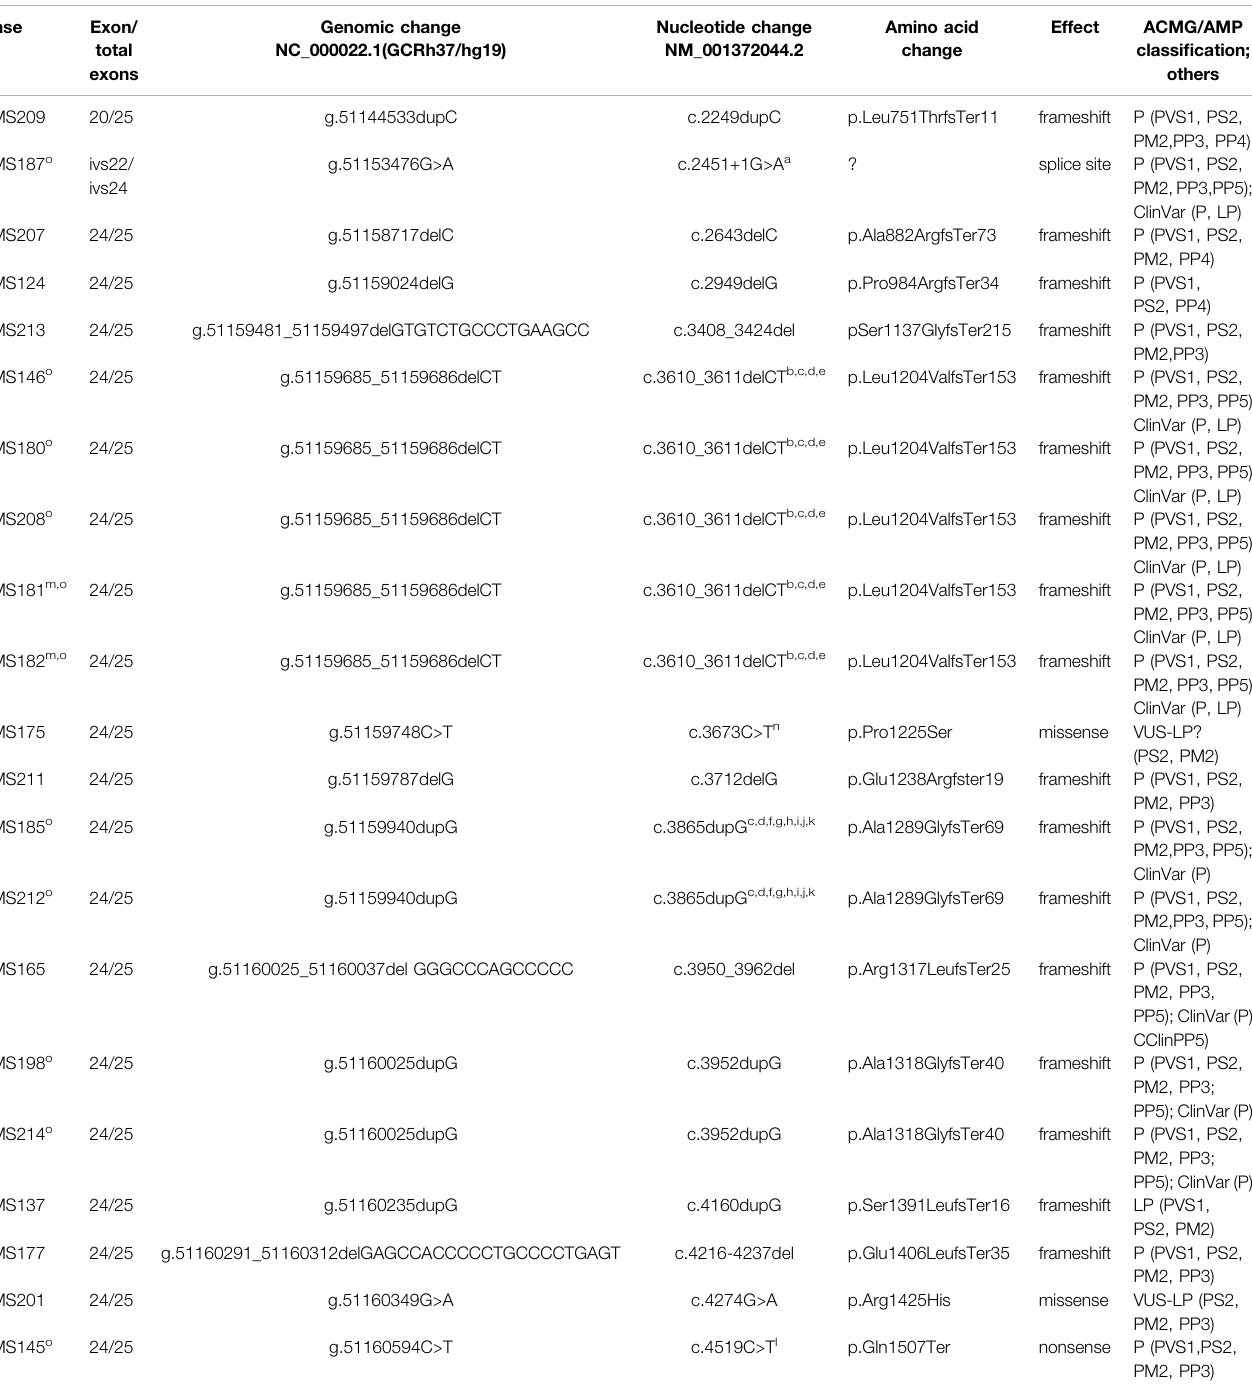
TABLE 4 | SHANK3 sequence variants identi fi ed in this